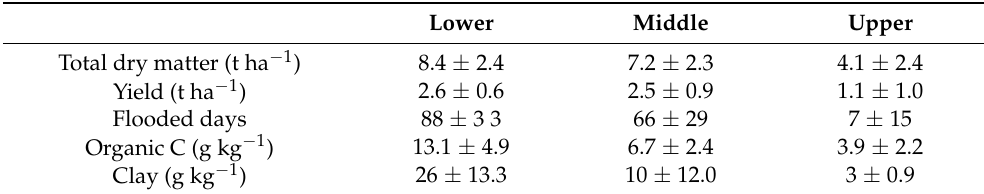
Table 3. Relationships of rice dry matter and yield at sites along a toposequence in a sandy terrain in Northeast Thailand with flooding regime, soil organic matter and clay